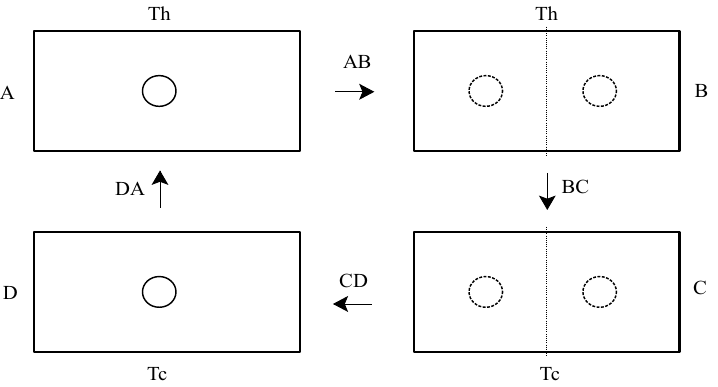
Figure 1. The sub-processes of the fractional quantum heat engine for the infinite well in a box of length 2a. In this schema boxes A and B interact a hot bath reservoir, boxes C and D interact a cold bath reservoir. The stages AB and CD represent the isothermal insertion and removal processes. The stages BC and DA denote the isochoric